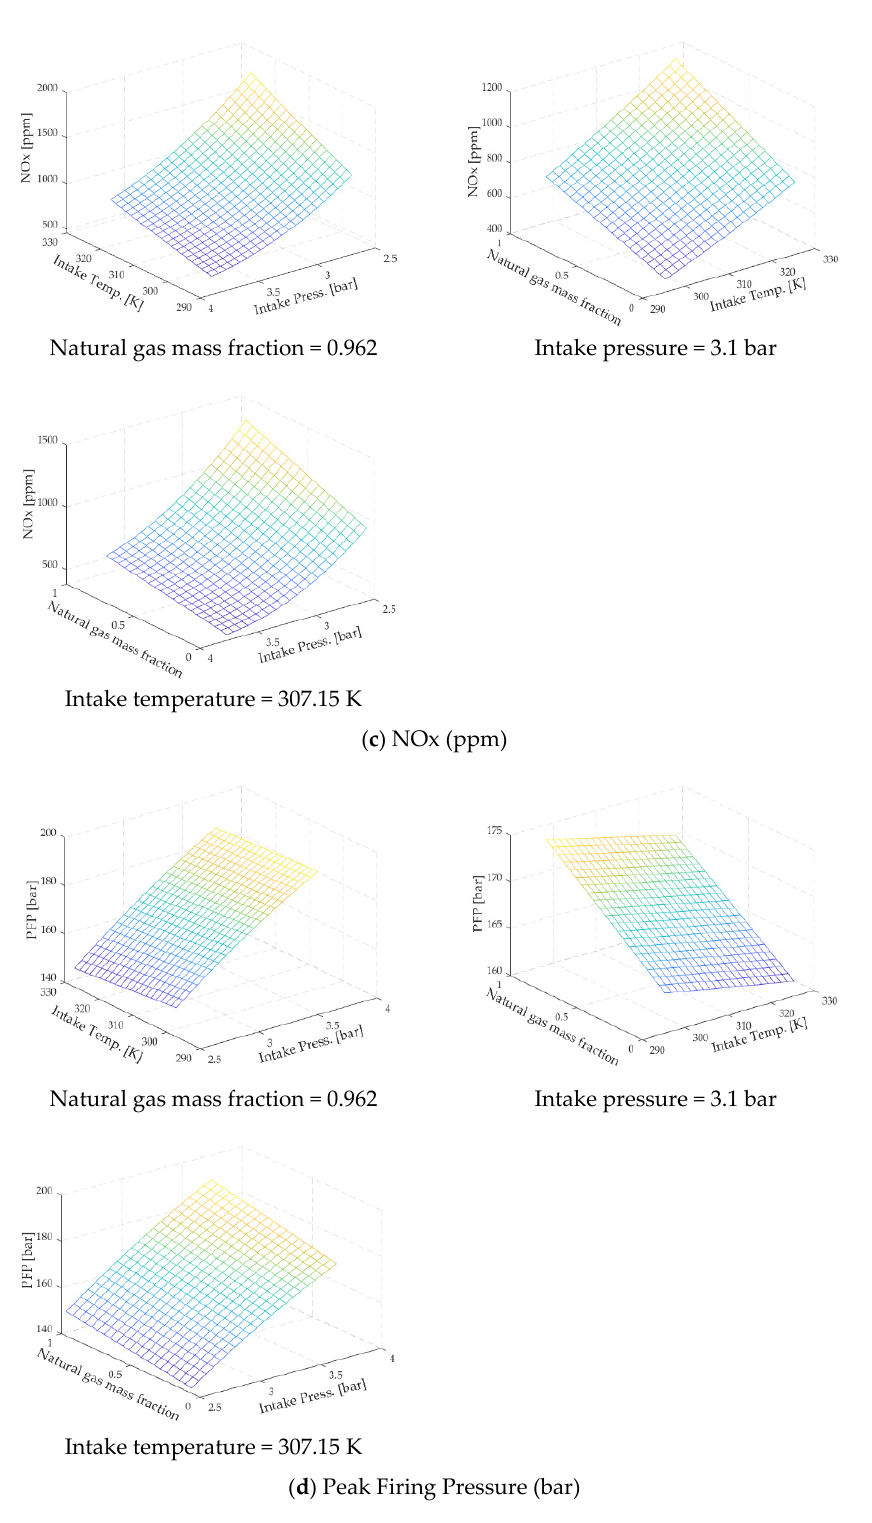
Figure 7. The surface of the different responses.